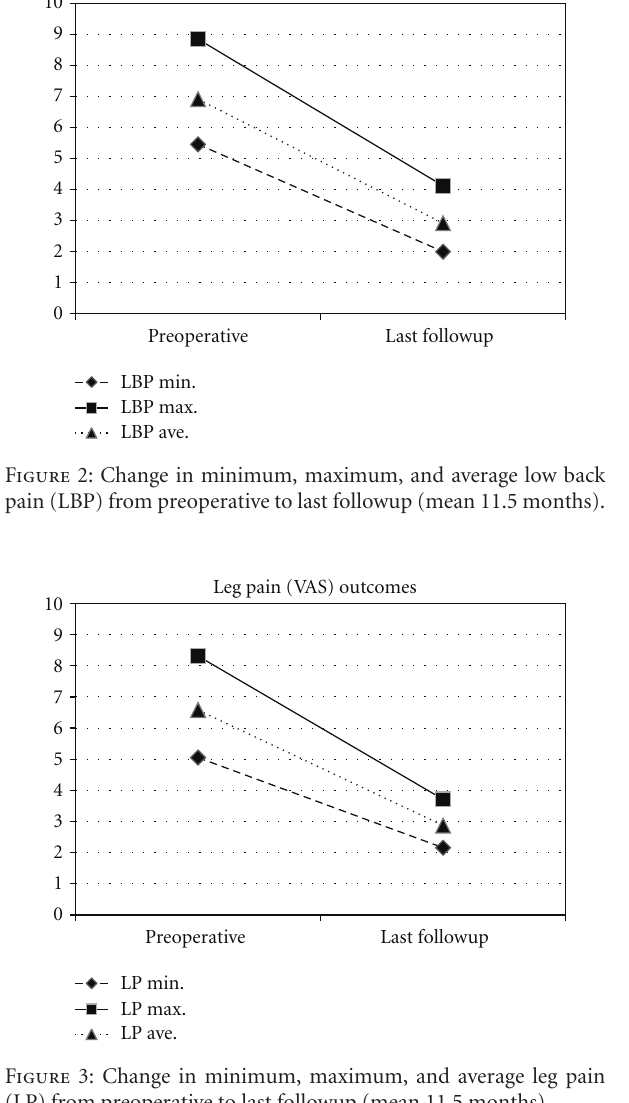
Figure 5: Coronal computed tomography (CT) showing solid arthrodesis at 12 months postoperative following L4-5